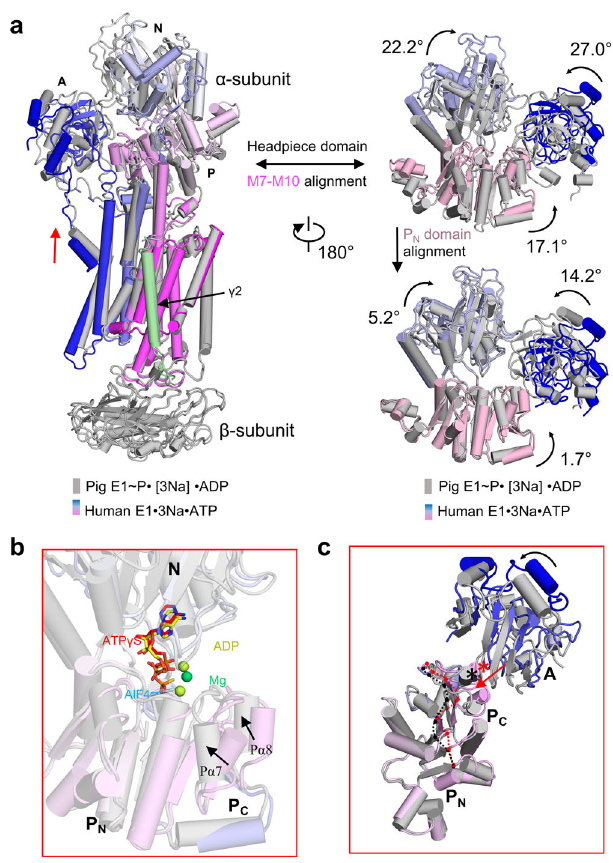
Fig. 4 P domain conformation change causes cytoplasmic gate closure. a Structural comparison of the E1·3Na·ATP (blue to magenta) with E1~P·[3Na]·ADP (grey) states with the movement of the M1 helix and cytosolic headpiece shown. The structures are superimposed with M7 – M10 or the P N domain (598 – 710 residues). Red arrows represent closing of the M1 sliding door. b , c The structures are superimposed with the P N domain (598 – 710 residues) between the E1·3Na·ATP and E1~P·[3Na]·ADP states. The ATP (red) and ADP (yellow) binding pockets between the N and P domains are shown in ( b ). The P N and P C half domains have a bent conformation in the E1·3Na·ATP state (indicated by the red dashed line) or an unbent con fi rmation in the E1~P·[3Na]·ADP state (indicated by the black dashed line), respectively. The A domain sitting on a helix (P α 8) are denoted with asterisk in E1·3Na·ATP (red) and in E1~P·[3Na]·ADP (black). Red arrow indicates movement of P α 8 during transition from the E1·3Na·ATP state to the E1~P·[3Na]·ADP